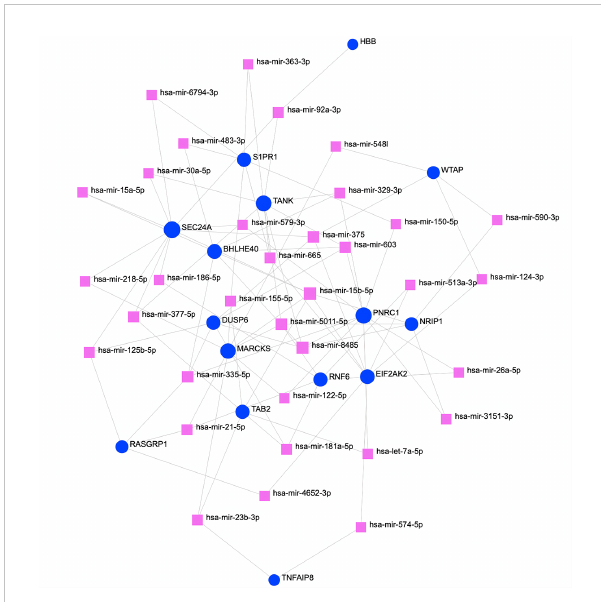
FIGURE 7 The regulatory interaction network of DEGs and miRNAs. The square nodes represent miRNAs, and gene symbols interact with miRNAs as circles. The larger the square or circle, the more important the miRNAs or DEGs are in this network. DEGs, differentially expressed